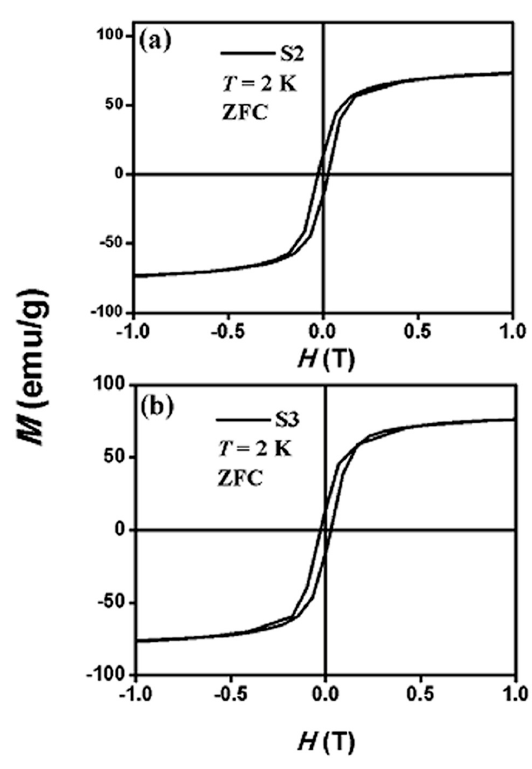
Figure 3. The applied magnetic field ( H ) versus the magnetization ( M ) at 2 K under zero field-cooling condition for ( a ) sample S2 and ( b ) sample S3. ZFC, zero field-cooling.